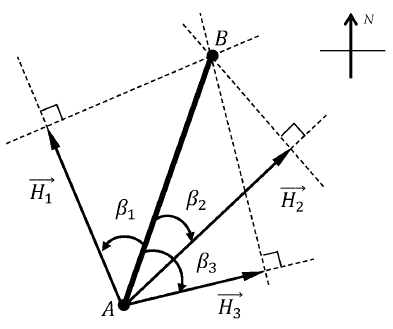
Figure 3 . Geometrical relationship between the true wave height and three measured wave heights. All the directions are measured with respect to north.